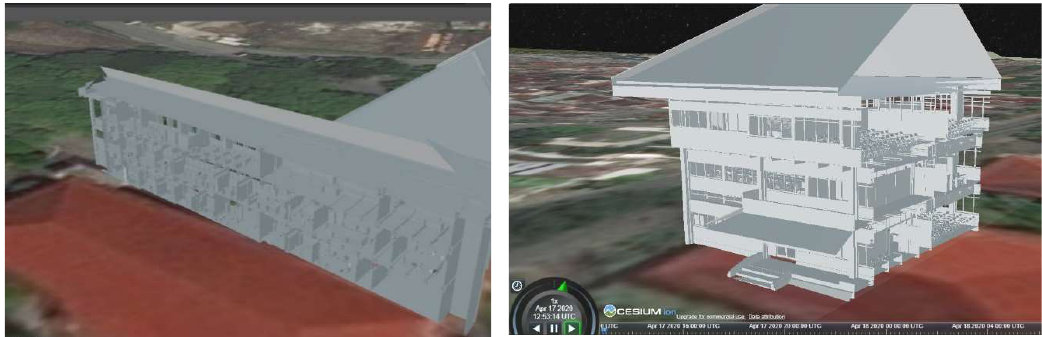
Figure 10. Representations of 3D cadastre case studies in the prototype.